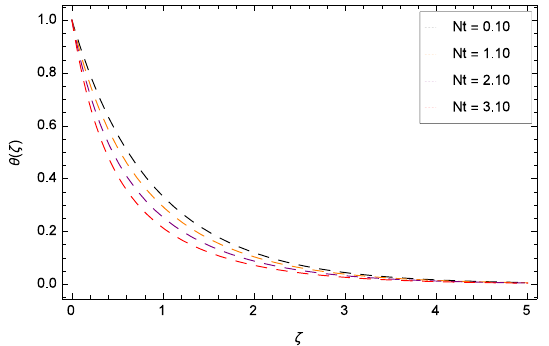
Figure 14. Pattern of graph curves on account of Nt .